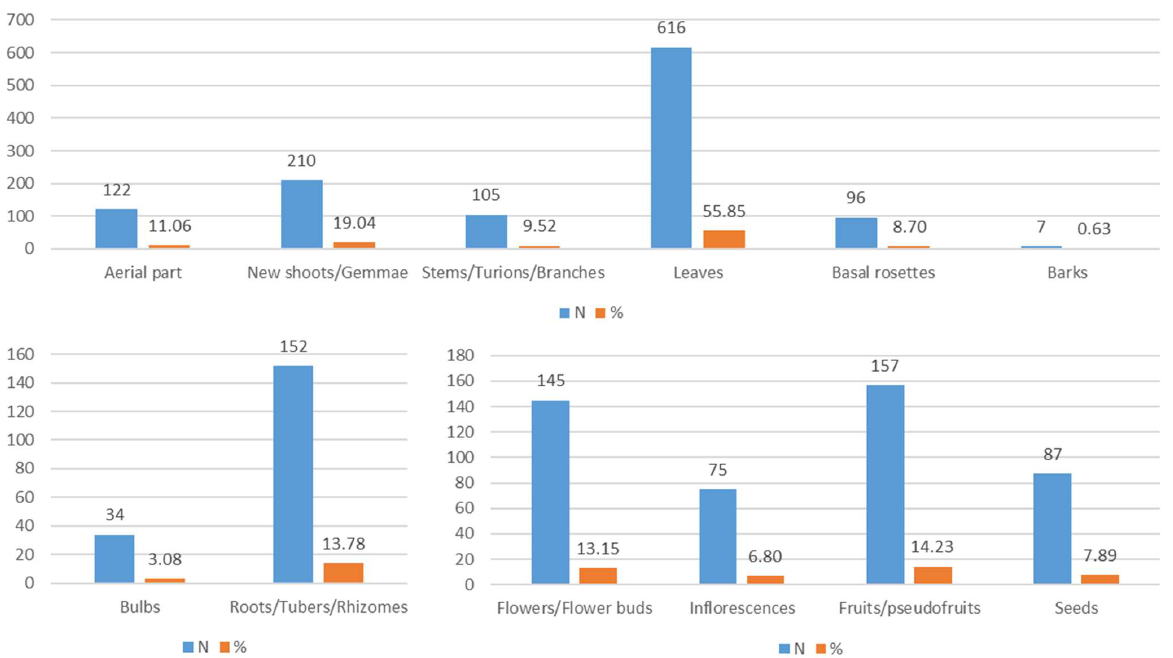
Figure 10. Parts of the plant used and their frequency in the whole database.